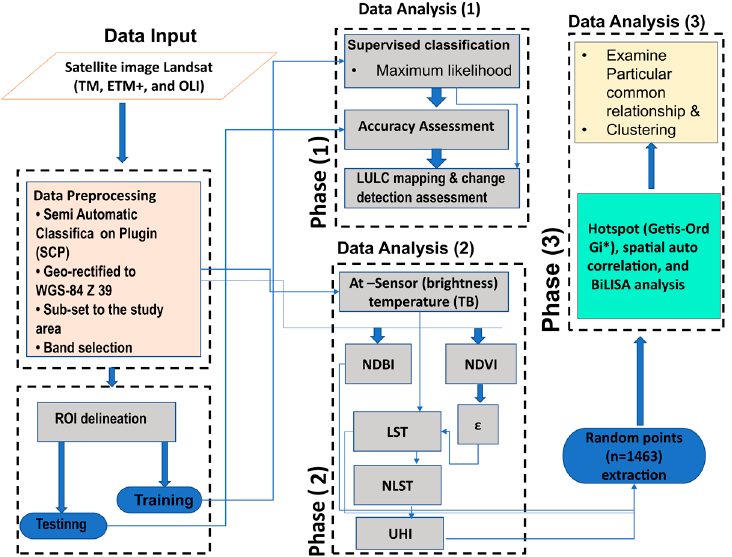
Figure 1. Description of the workflow of the methodology used in this research.